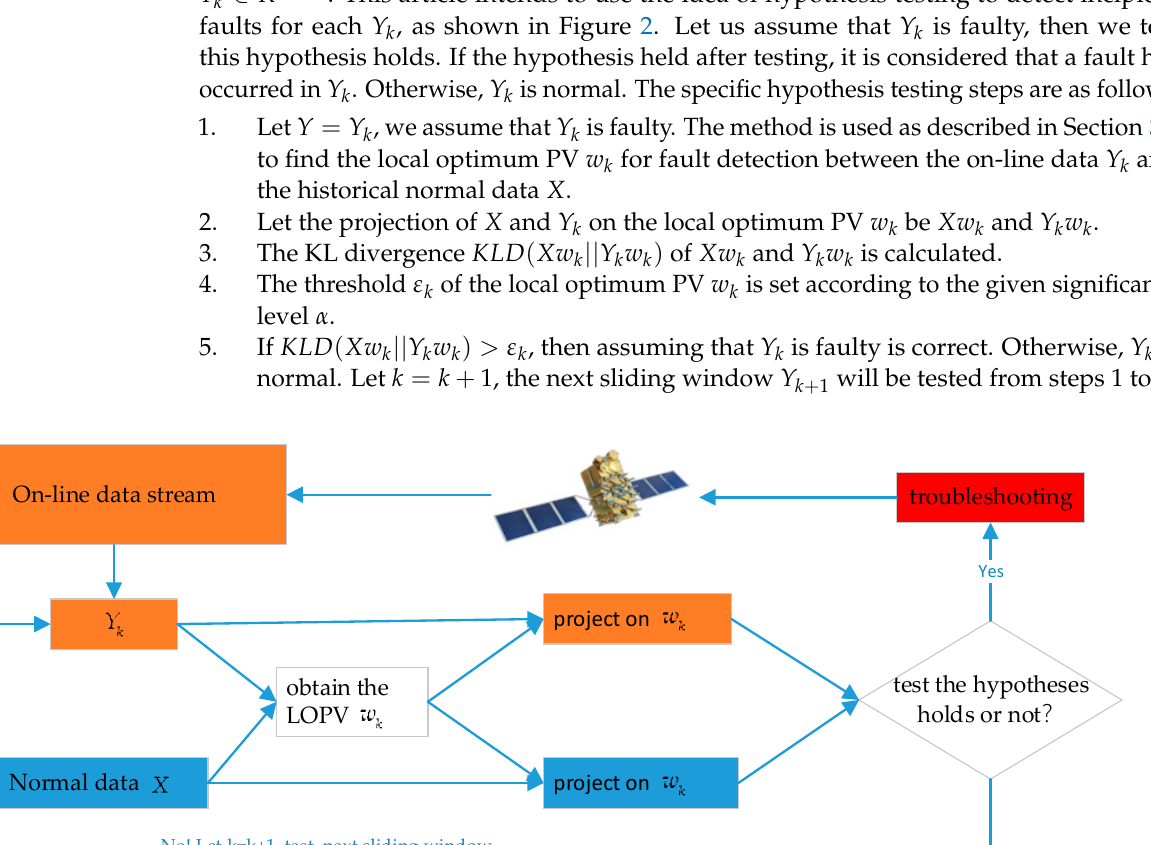
Figure 2. The idea of hypothesis testing to detect incipient faults for each